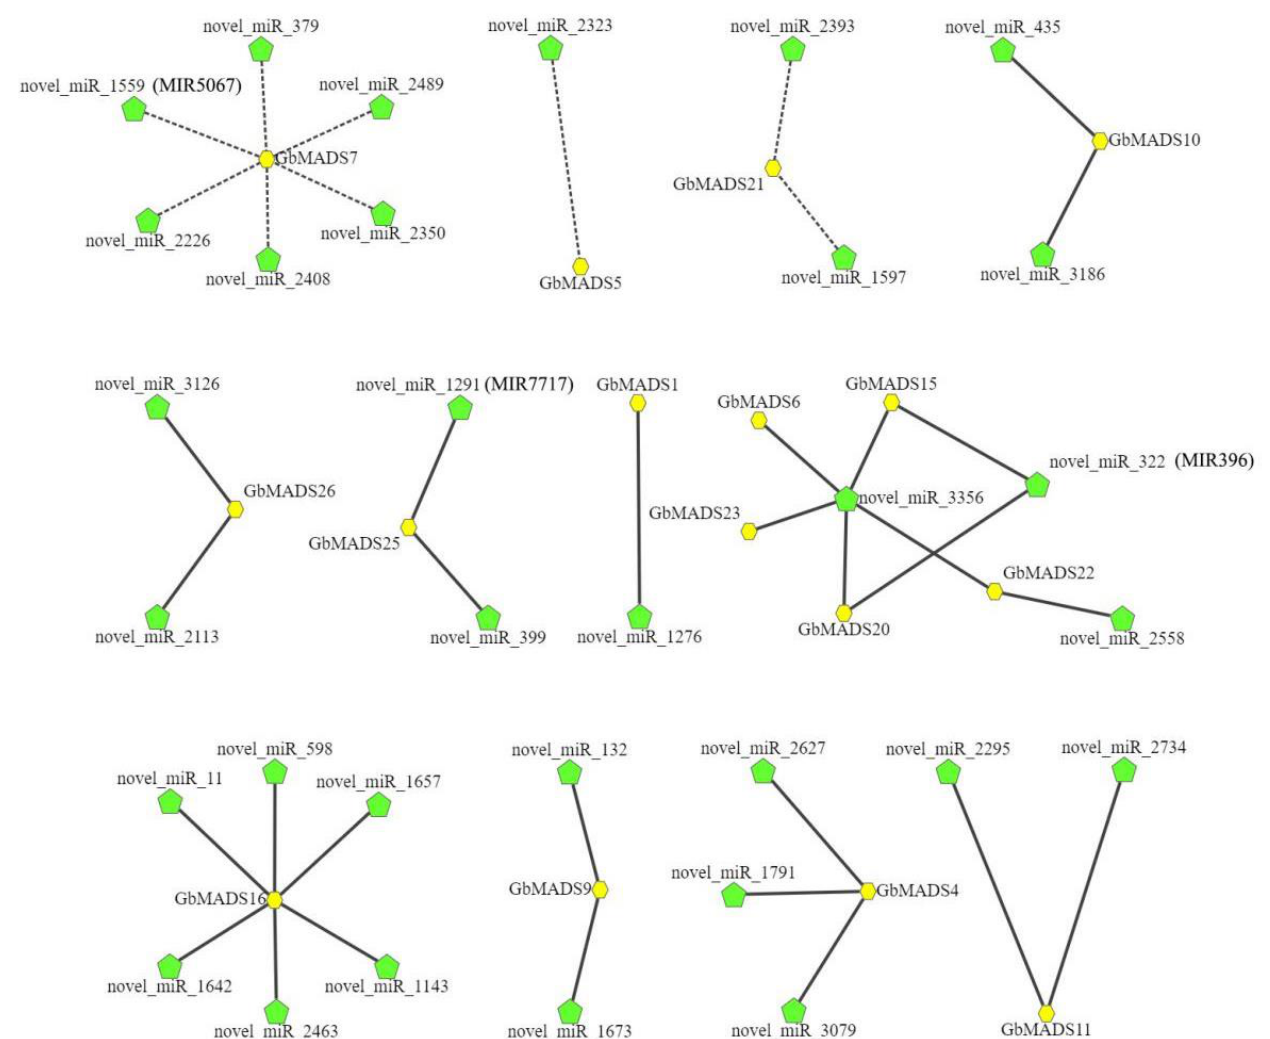
Figure 5. miRNA-directed network diagram of GbMADS genes in G. biloba . The yellow hexagon represents GbMADS genes, and the green Pentagon represents miRNA.